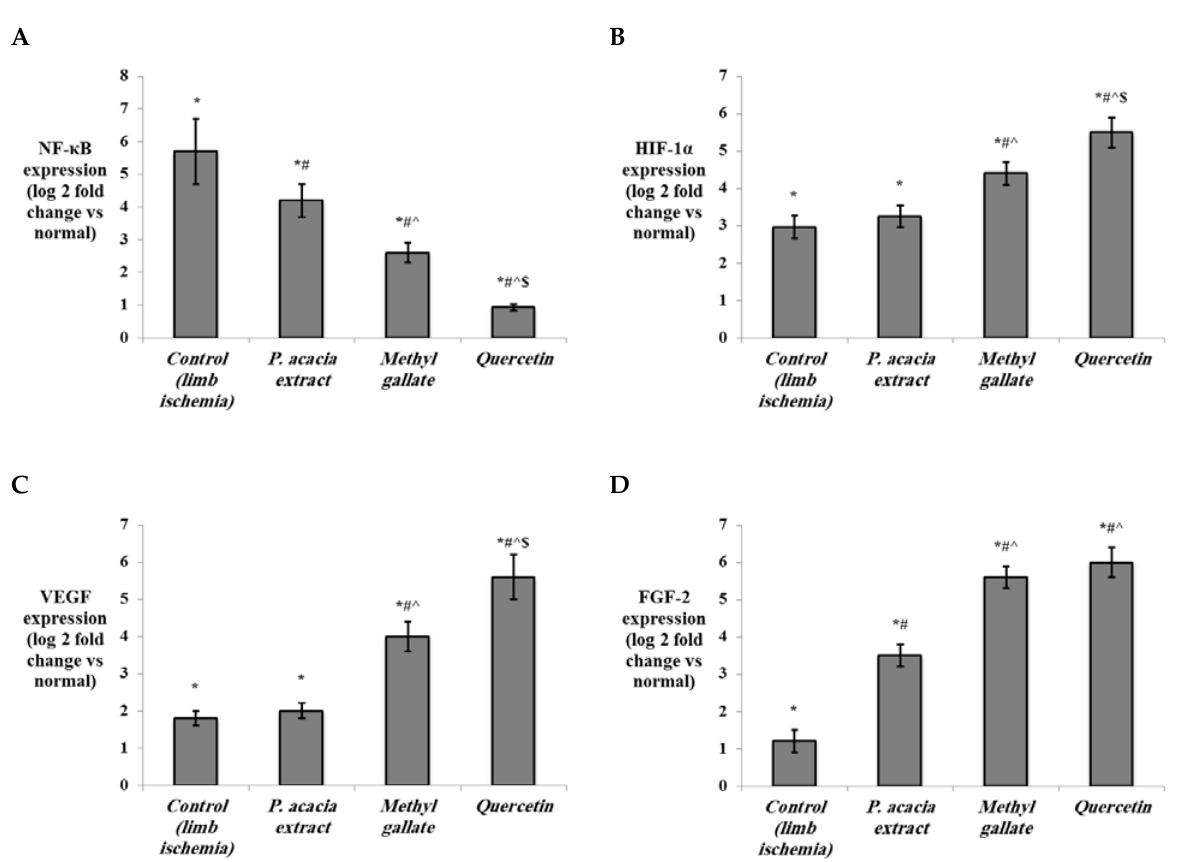
Figure 8. The effect of the P. acacia extract and its isolated compounds (methyl gallate and quercetin) on the expression levels of ( A ) NF- κ B, ( B ) HIF-1 α ( C ) VEGF, and ( D ) FGF-2 in the hind limb tissue of the experimental rats. ( n = 8). NF- κ B = nuclear factor kappa B; HIF-1 α = hypoxia inducible factor-1 alpha; VEGF = vascular endothelial growth factor; FGF-2 = fibroblast growth factor-2. Data are expressed as mean ± SD of the log 2 fold change relative to the normal group (log 2 (1) = zero, i.e., base line). Data were analyzed using one-way ANOVA followed by Bonferroni’s post hoc test. * Significantly different compared to the normal group, # significantly different compared to the hind limb ischemia control group, ˆ significantly different compared to the group treated with the P. acacia extract, $ significantly different compared to the group treated with methyl gallate. Values were considered significantly different at p < 0.05.